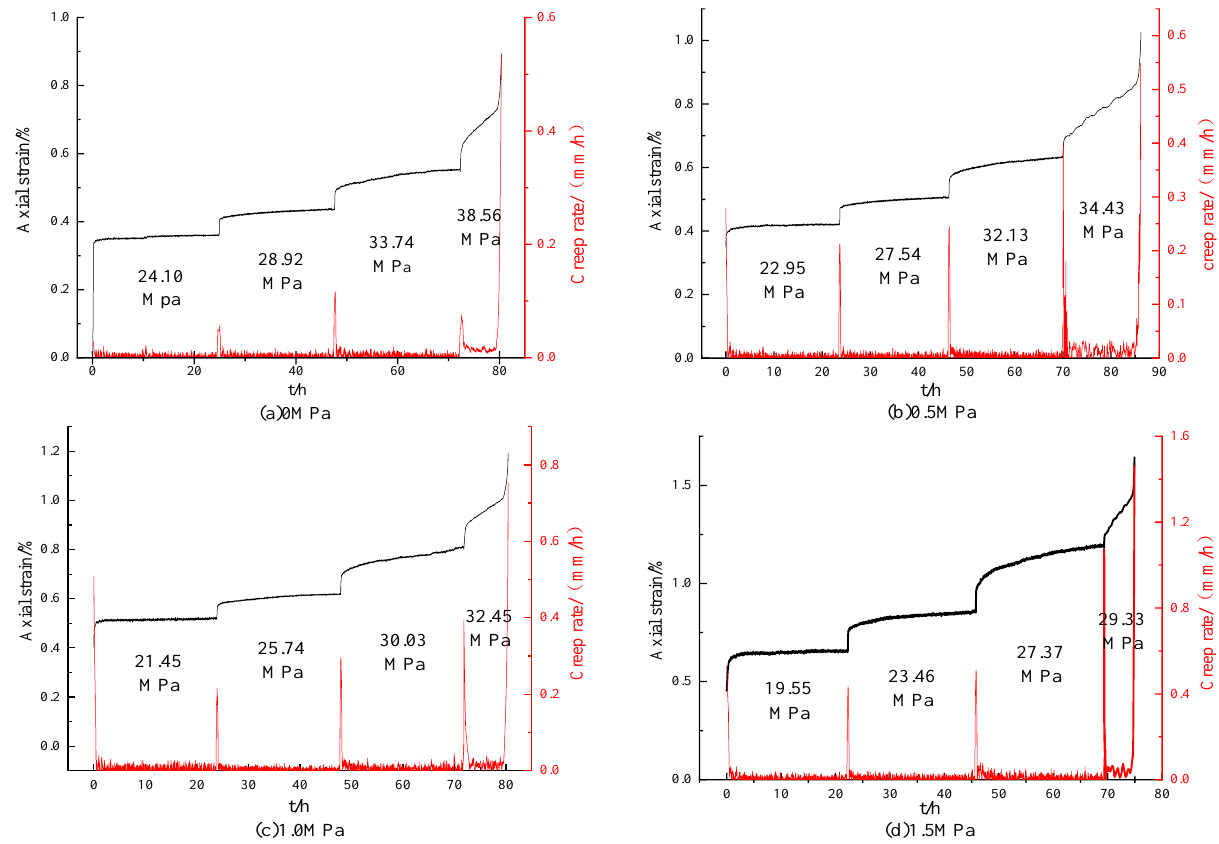
Figure 7. Creep rate – time curve under different seepage pressure.